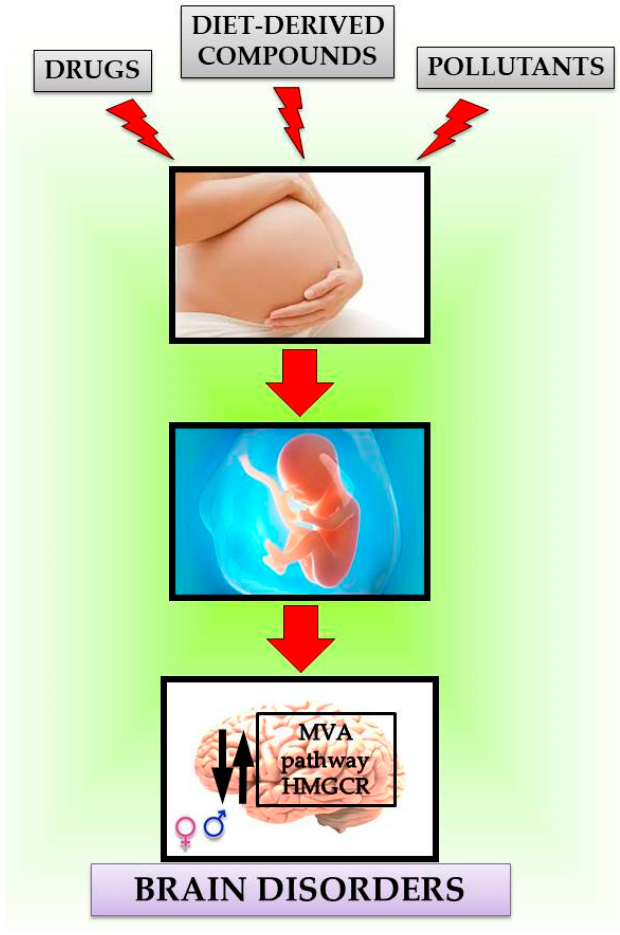
Figure 3. Working model.